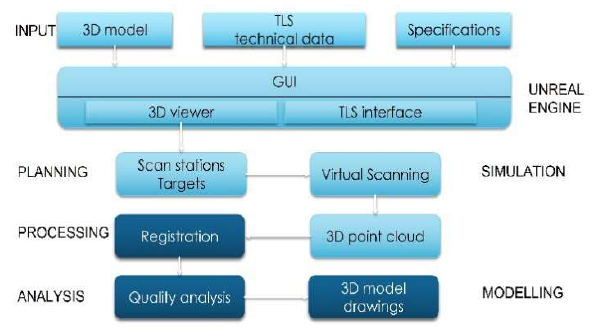
Figure 1. Simulator functionality. Light blue textboxes in Figure 1 top show the functionality covered by VRscan3D. Dark blue textboxes illustrate further processing steps of the simulated data using user-selected software. Users will be able to select and configure custom scanner parameters like resolution, field of view, min. and max. range, angular accuracy and range